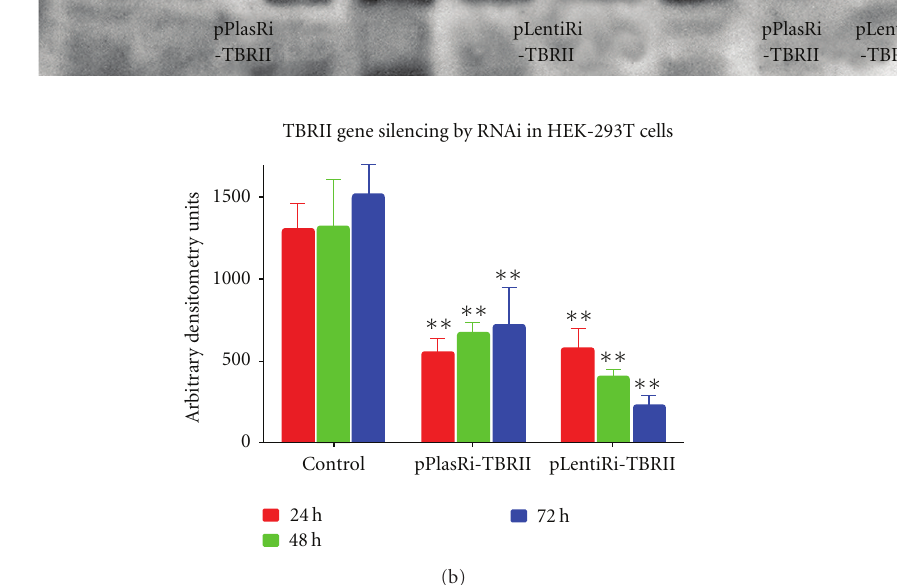
Figure 2: Gene silencing of TBRII by RNAi in HEK-293T cells. pPlasRi-TBRII and pLentiRi-TBRII were transfected into HEK-293T cells. FITC-fluorescence immunohistochemistry of TBRII is demonstrated in the upper two panels. The upper panel demonstrates pPlasRi- TBRII and the lower panel demonstrates pLentiRi-TBRII. Both groups showed a decrease of TBRII expression. TBRII was also evaluated by Western blotting (blot panel) and semiquantified by densitometry (graphical presentation). There was significant inhibition of TBRII after both transfections at all time points ( ∗∗ P < . 01 in comparison with controls), but the lentiviral construct increased with time and caused significantly greater silencing at 72 hrs than pPlasRi-TBRII ( P < .